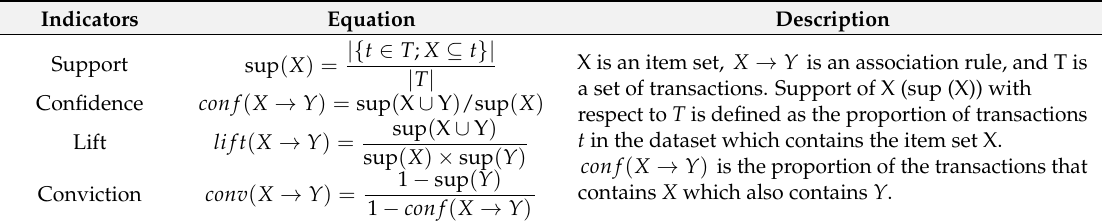
Table 5. The performance indicators for the association